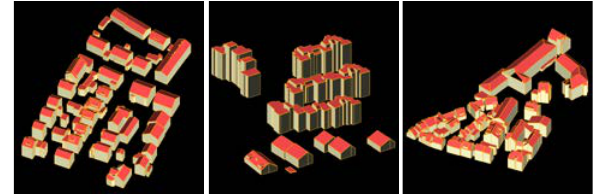
Figure 6. Reconstructed models of Vaihingen test areas. From left to right: area 1, area 2 and area 3.